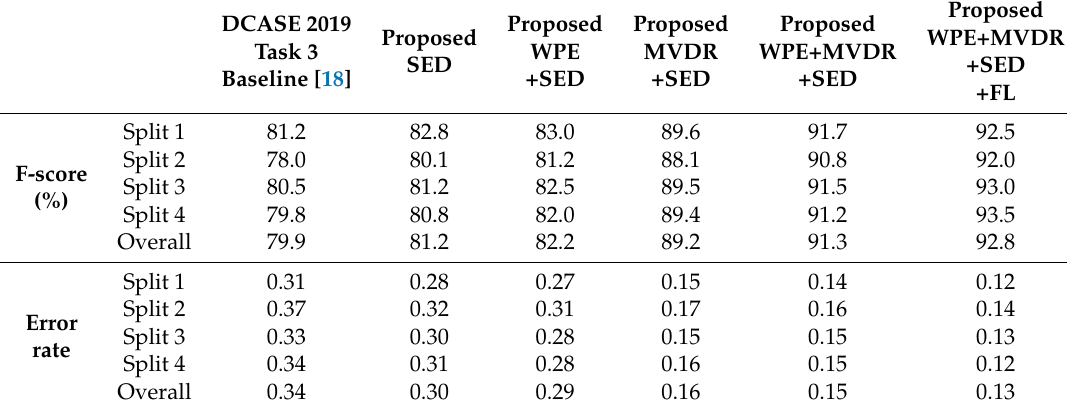
Table 3. F-score and error rate (ER) results on the TAU Spatial Sound Events 2019-Ambisonic development dataset.